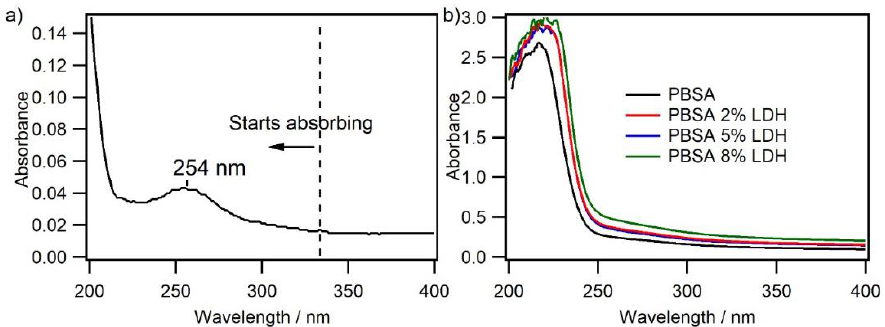
Figure 6. ( a ) Solid state UV absorption spectrum of SORBACID ® 911, and UV–VIS spectra of ( b ) PBSA (black line) and PBSA with 2 wt% (red line), 5 wt% (blue line), and 8 wt% (green line) LDH.